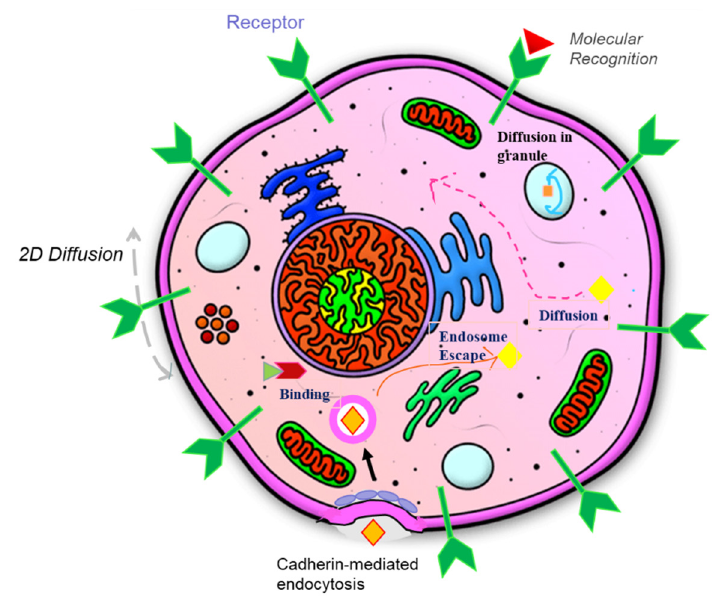
Figure 10. Transport and binding kinetics including ligand-receptor binding, cadherin-mediated endocytosis, diffusion in cytoplasm, diffusion in membrane-bound organelles, escape from endosomes, etc., for maintaining the homeostasis of cellular functions.